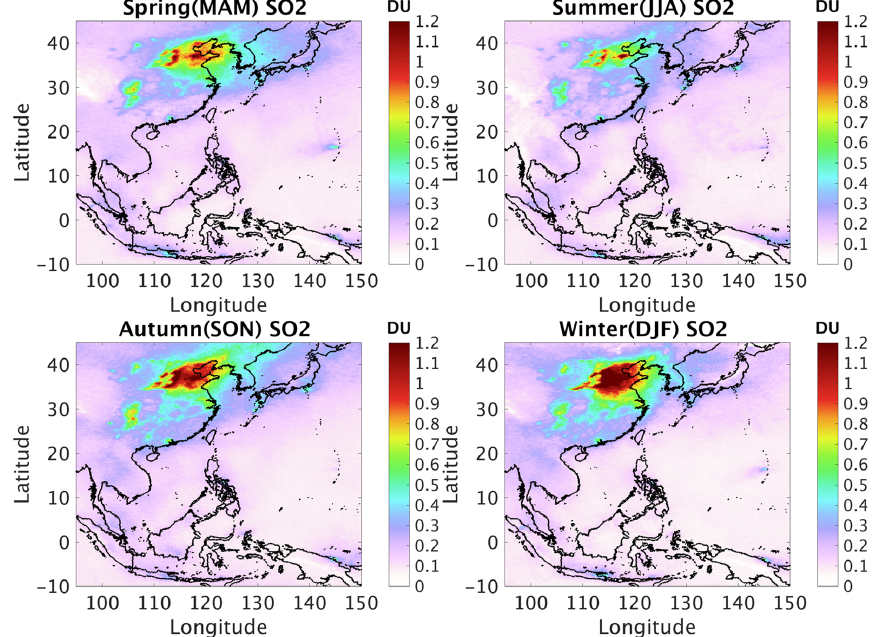
Figure 3. Spatial distribution of planetary boundary layer (PBL) sulfur dioxide (SO 2 ) from Aura ozone monitoring instrument (OMI) for each season, 2005–2015. (Unit: Dobson units; 1DU = 2.69 × 10 16 molecules cm − 2